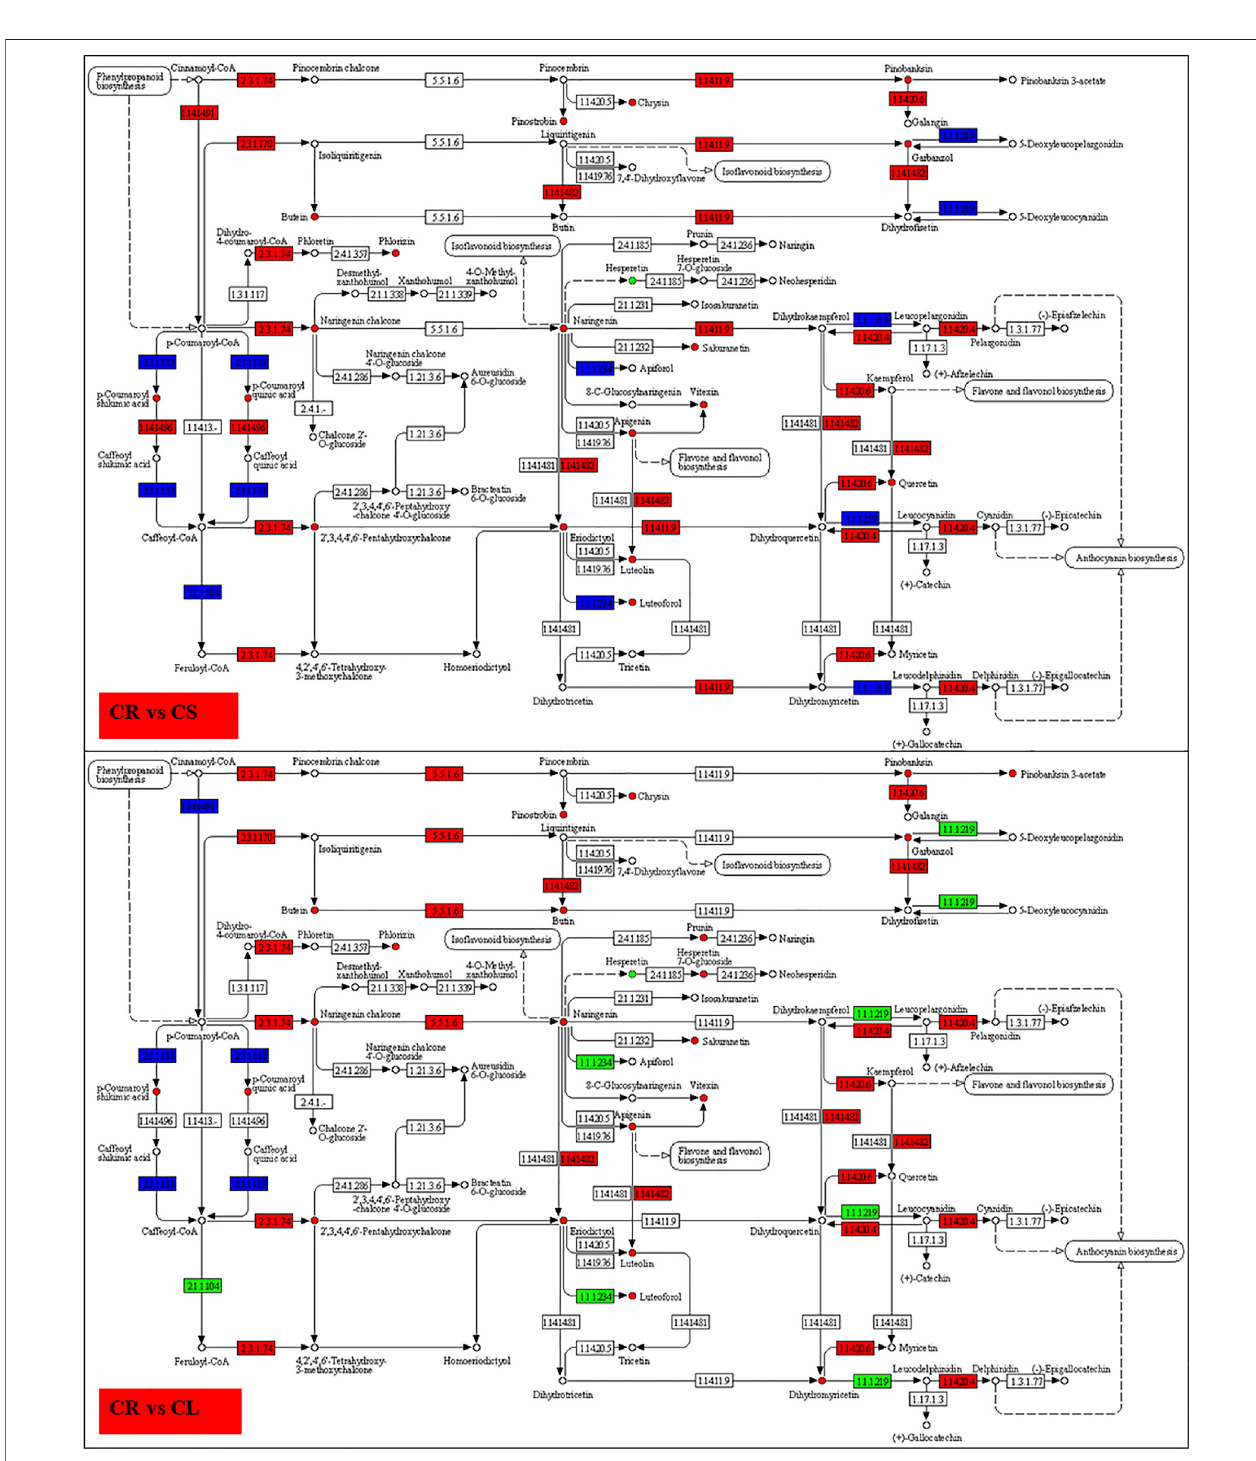
FIGURE 9 | Enrichment of DEGs and DAMs on fl avonoid biosynthesis pathway in CR vs. CS and CR vs. CL. The DAMs highlighted in red and green were accumulated in higher and lower quantities in CS and CL as compared to CR, respectively. The DEGs in red, green, and blue represent the genes that showed higher, lower, and mixed expression, respectively, in CS and CL as compared to CR.